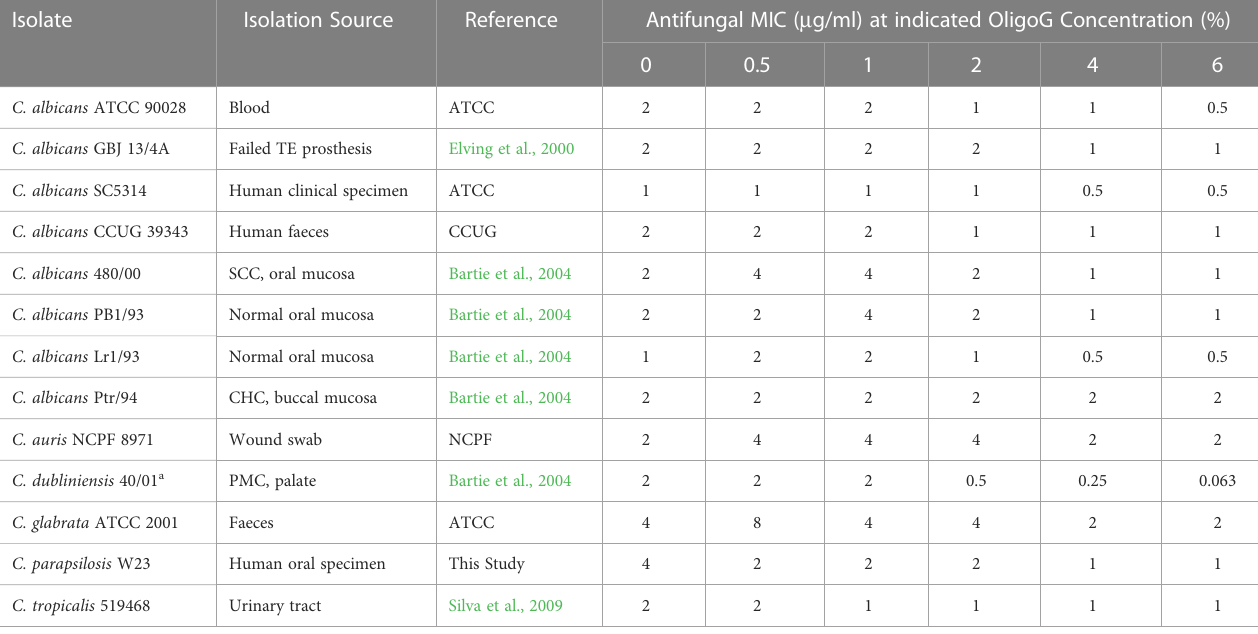
TABLE 1 Candida strains, sources, and MIC ( m g/ml) of nystatin alone and with increasing concentrations of OligoG (0.5, 1, 2, 4 and 6%; n=3).